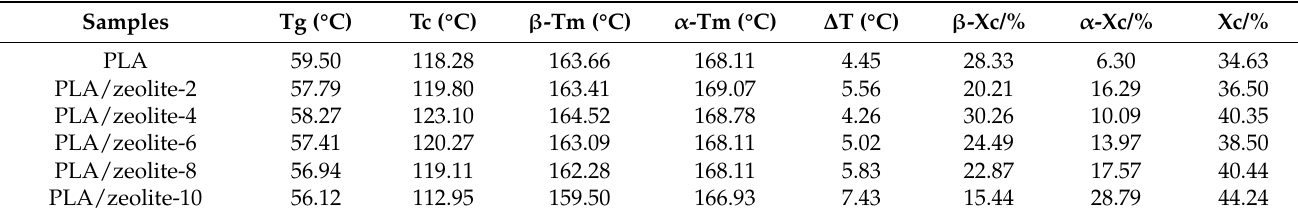
Table 2. Crystallization and melting parameters of PLA and PLA/zeolite